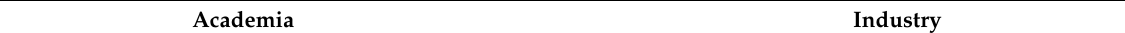
Table 2. Pilot study’s